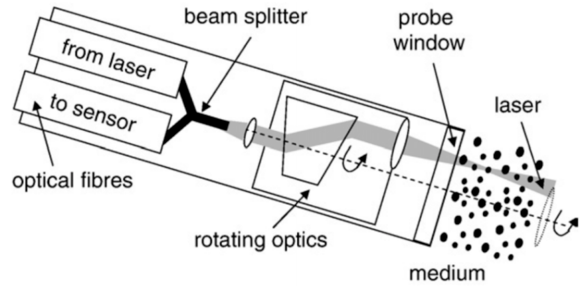
Figure 1. Schematic drawing of an FBRM probe [19]. Re-used with permission from Elsevier